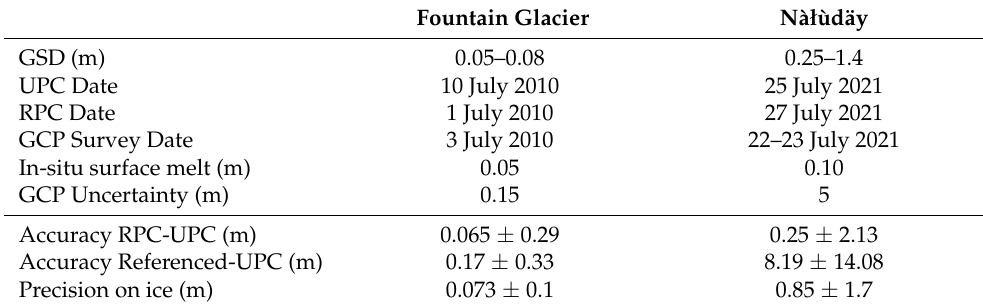
Figure 6. ( A ) The difference between the 10 July UPC and the RPC (1 July) for Fountain Glacier, after the UPC has been georeferenced. ( B ) The difference between the 10 July UPC and the 11 July point cloud, after georeferencing. White points in ( A , B ) show differences between − 0.05 and 0.05 m. Table 1. Characteristics and results from case studies at Fountain Glacier, NU, and Nàłùdäy, YT. Fountain